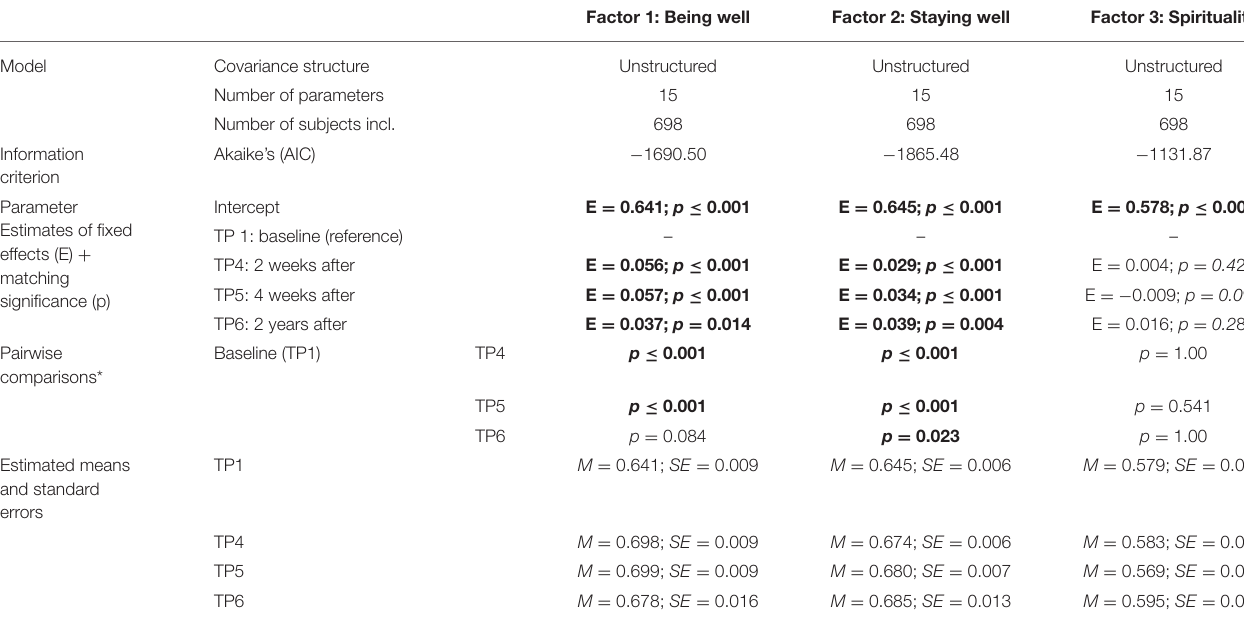
TABLE 7 | Relevant outcomes Mixed Model analyses with factor scores across the four timepoints (TPs). Factor 1: Being well Factor 2: Staying well Factor 3: Spirituality